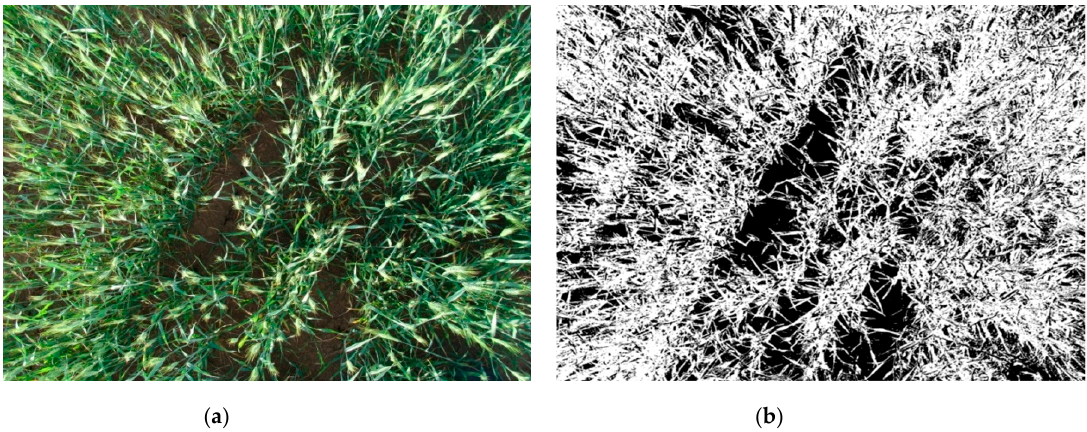
Figure 10. Canopy coverage extraction from in-situ photo taken using python image processing packages. Left panel ( a ) is the original photo and the right panel ( b ) shows white ratio calculated as green areas and black to the bare soil in wheat sample field.